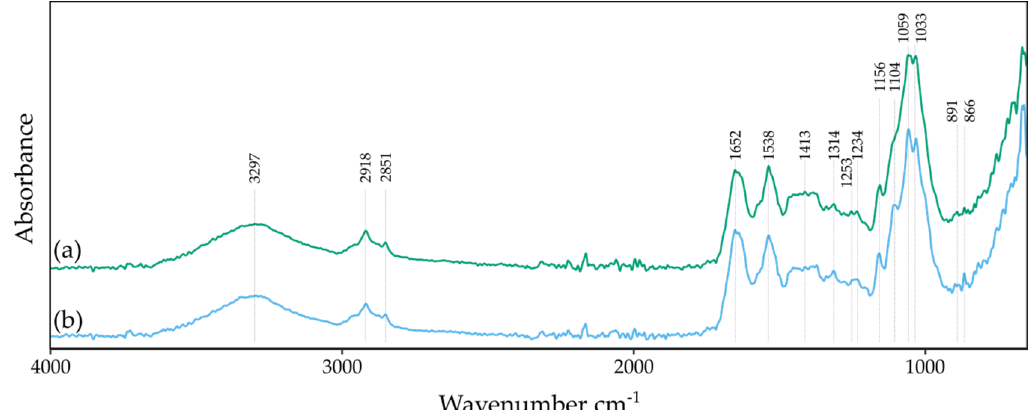
Figure 11. The FTIR-ATR spectra of BNC were produced in ( a ) SH medium supplemented with 0.5% vitamin C and ( b ) SH medium supplemented with 1.0% vitamin C.